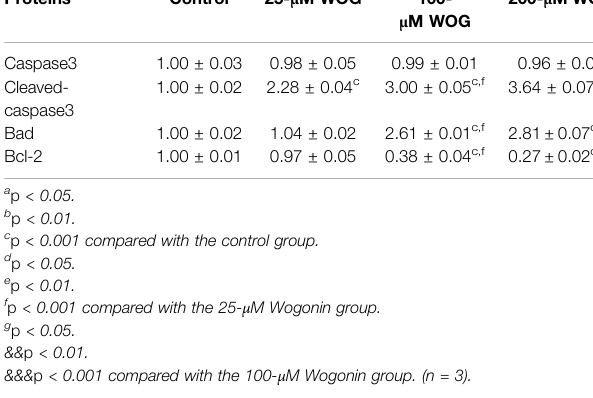
TABLE 2 | The relative expression of caspase-3/cleaved-caspase-3, Bad, and Bcl-2 proteins. Proteins